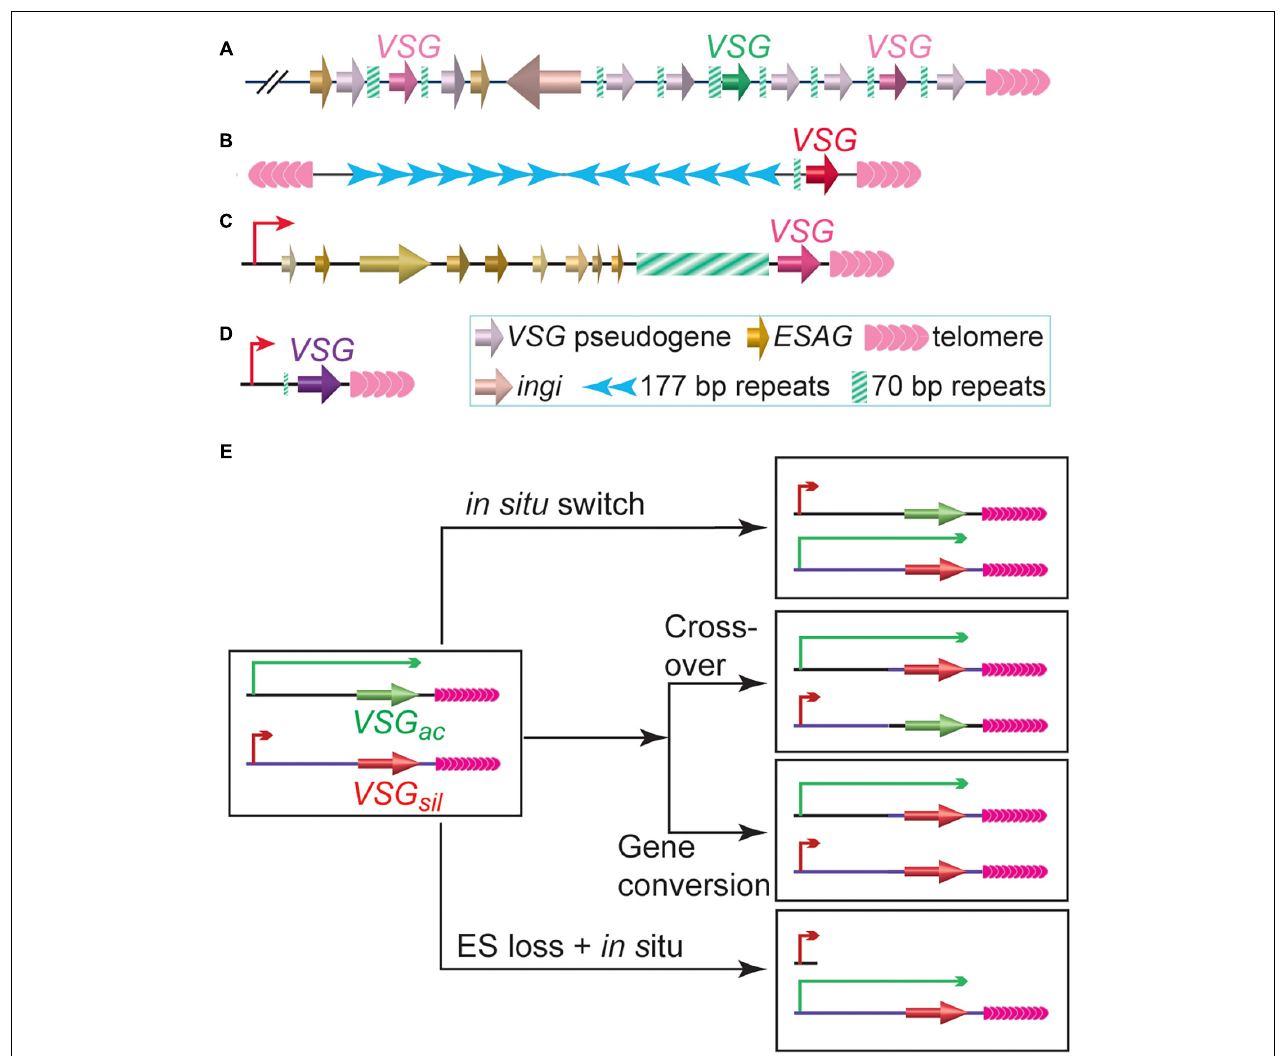
FIGURE 1 | Trypanosoma brucei has a large VSG gene pool. (A) A representative subtelomeric VSG gene array. (B) A typical minichromosome with a subtelomeric VSG gene. (C) A representative bloodstream form VSG expression site, which is a polycistronic transcription unit and can be expressed while T. brucei proliferates in its mammalian host. (D) A representative metacyclic VSG expression site, which is a monocistronic transcription unit and can be expressed while T. brucei resides in the salivary gland of its insect vector. (E) Major VSG switching pathways. VSG ac stands for the originally active VSG . VSG sil stands for an originally silent VSG